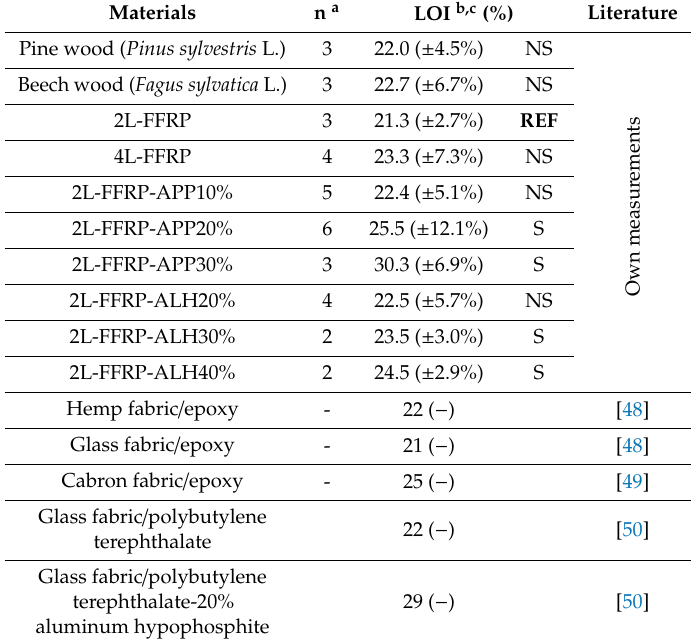
Table 4. Limited oxygen index (LOI) values of FFRP and other materials as the reference. Materials n a LOI b,c (%) Literature Pine wood ( Pinus sylvestris